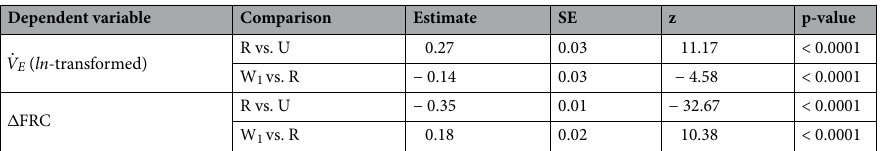
Table 3. Analysis of breathing during initial experimental conditions. The mixed-effects regression models used to test these contrasts accounted for a subject’s age, their BMI, and the experimental phase in the fixed effects, and included a random effect of subject identity to account for repeated measures (n = 911 breaths from 17 subjects in phases R, U, and W 1 ). To appropriately model the variances, the analysis for (cid:31) FRC accounted for unequal variance across phases. The table provides test statistics for post-hoc contrasts of specific comparisons. U = initial standing upright measurement; R = unweighted prone measurement; W 1 = first minute of weighted prone